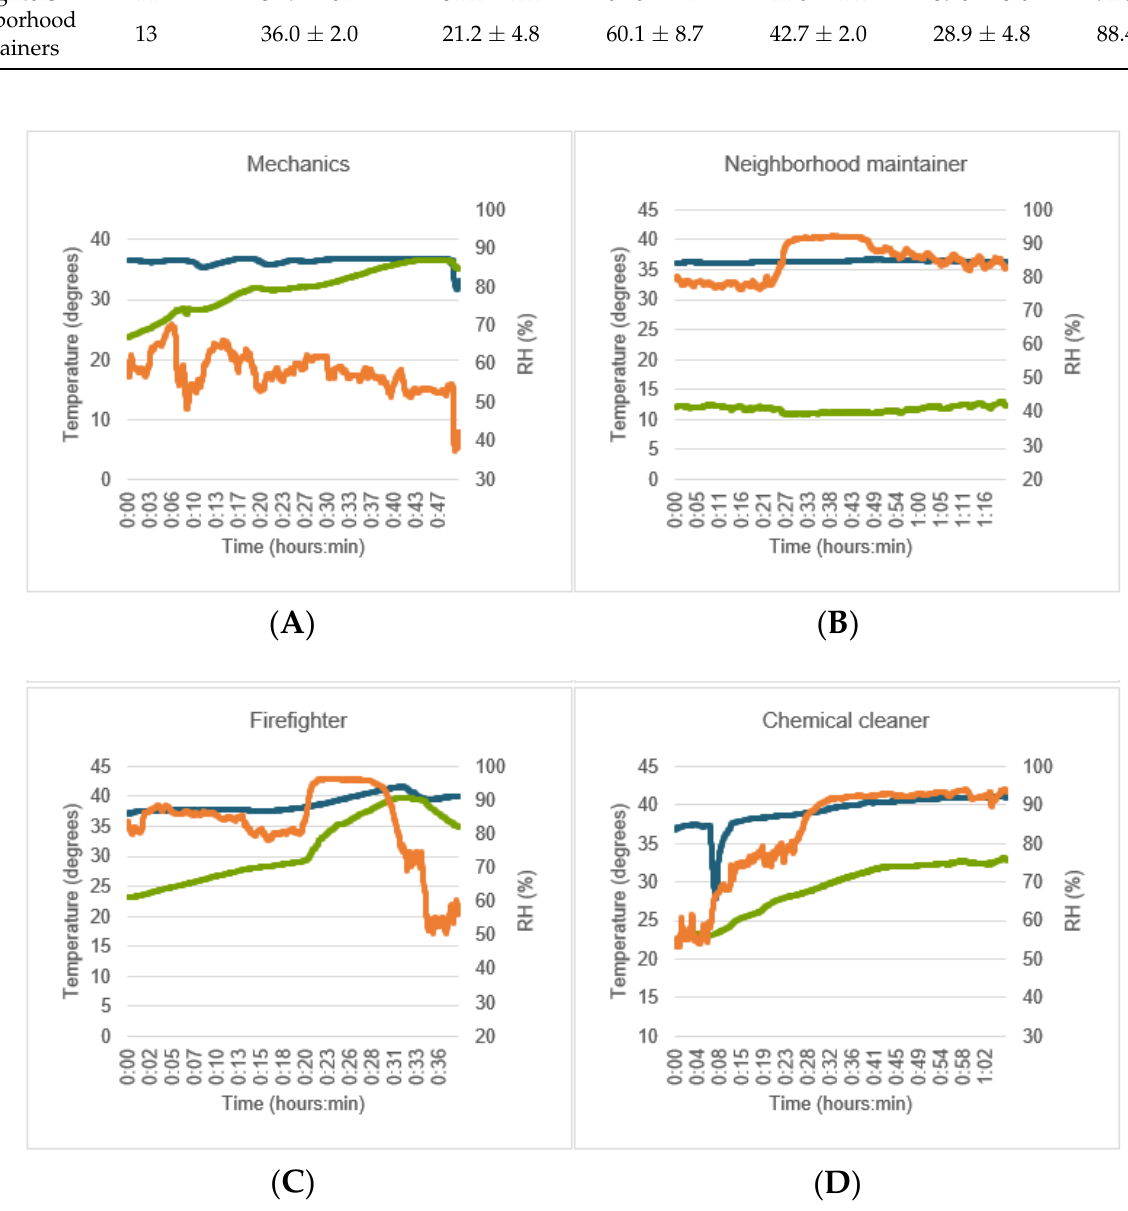
Figure 6. Individual graph during the performance of the job. ( A ) Mechanics; ( B ) neighborhood maintainer; ( C ) firefighters; ( D ) chemical cleaner. Ear canal temperature (°C) (dark blue), nearby micro-climate temperature (°C) (green) and relative humidity (RH) (%) (orange) of 4 subjects with different jobs.